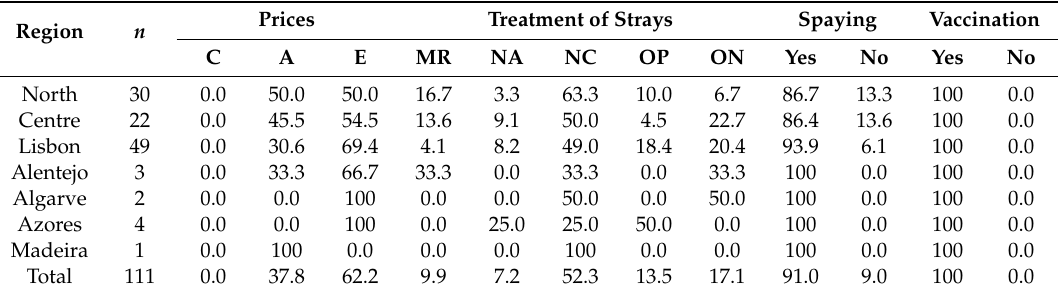
Table 6. Opinion of Portuguese pet owners on veterinary practice prices (%), treatment of stray animals (%), spaying and neutering (%), and vaccination of pets (%). Prices Treatment of Strays